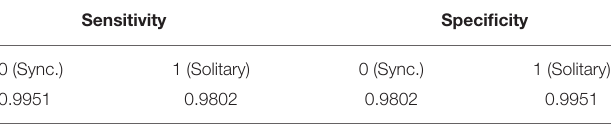
TABLE 7 | Sensitivity and specificity of MLP-NN predictive model for multilayer network. Sensitivity